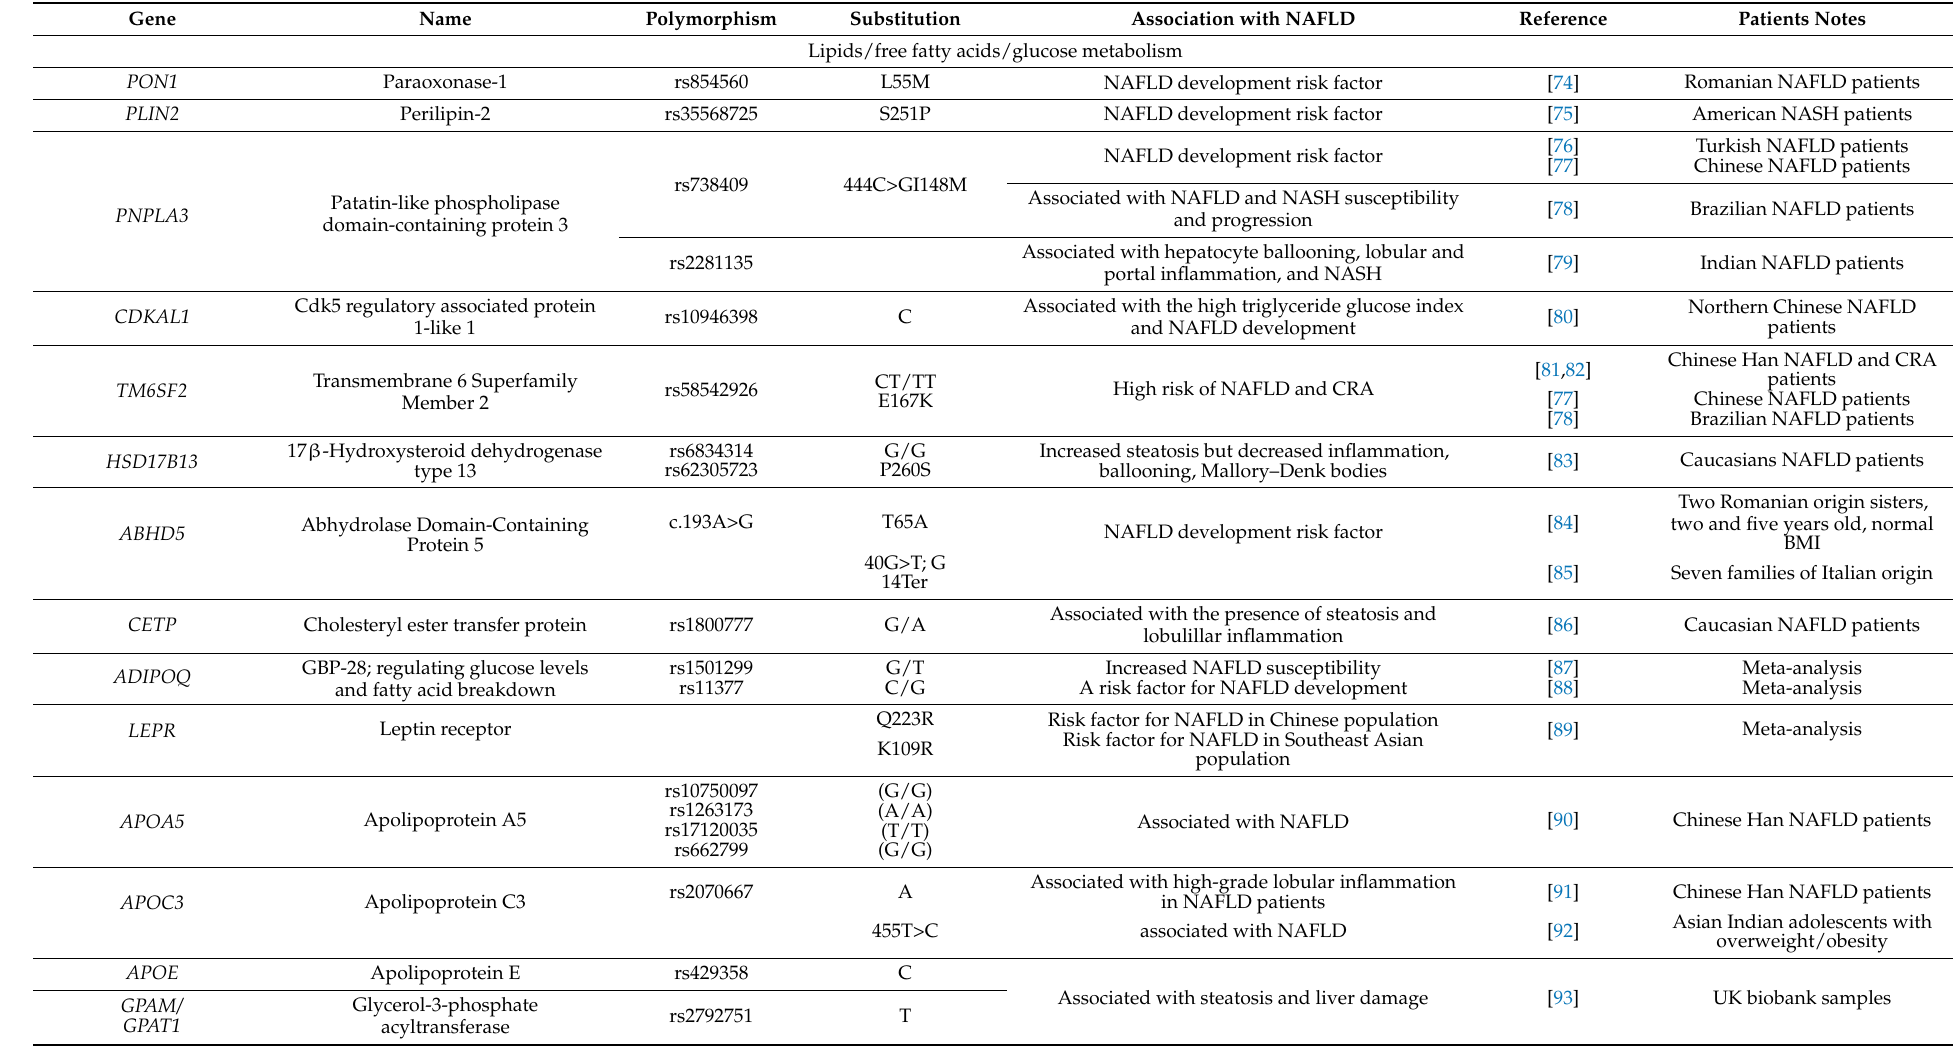
Table 1. List of Single-nucleotide polymorphism sites linked to